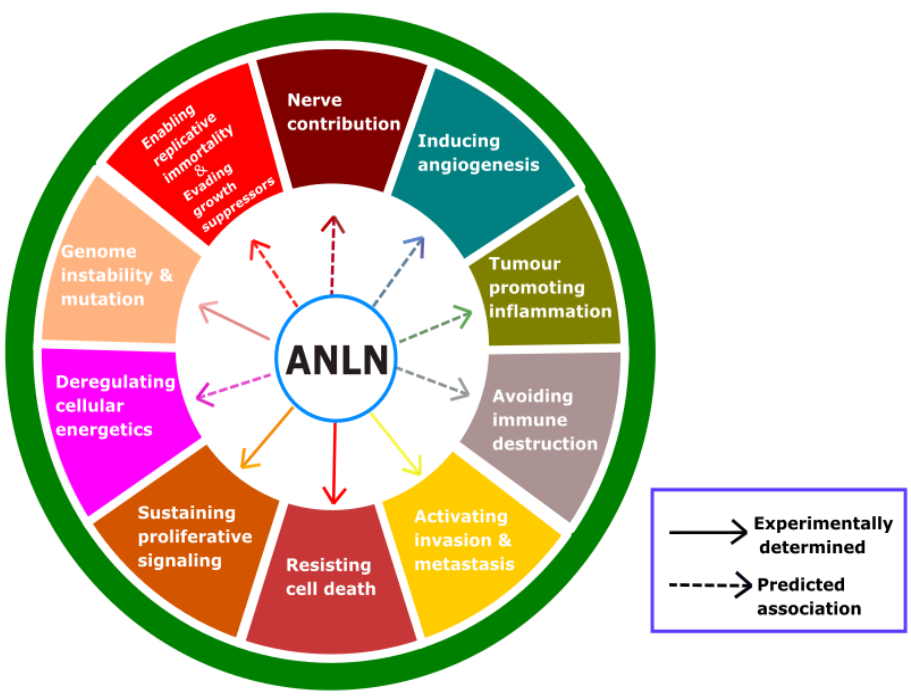
Figure 5. E ff ects of ANLN on cancer progression; this illustration encompasses eleven stimulating e ff ects of ANLN on the hallmarks of cancer, including experimentally determined e ff ects and predictable e ff ects based on the association of ANLN with events related to each predicted hallmark. Separate hallmarks of cancer are depicted with di ff erently colored fields. Table 2. The role of ANLN on the hallmarks in different cancer cell lines.